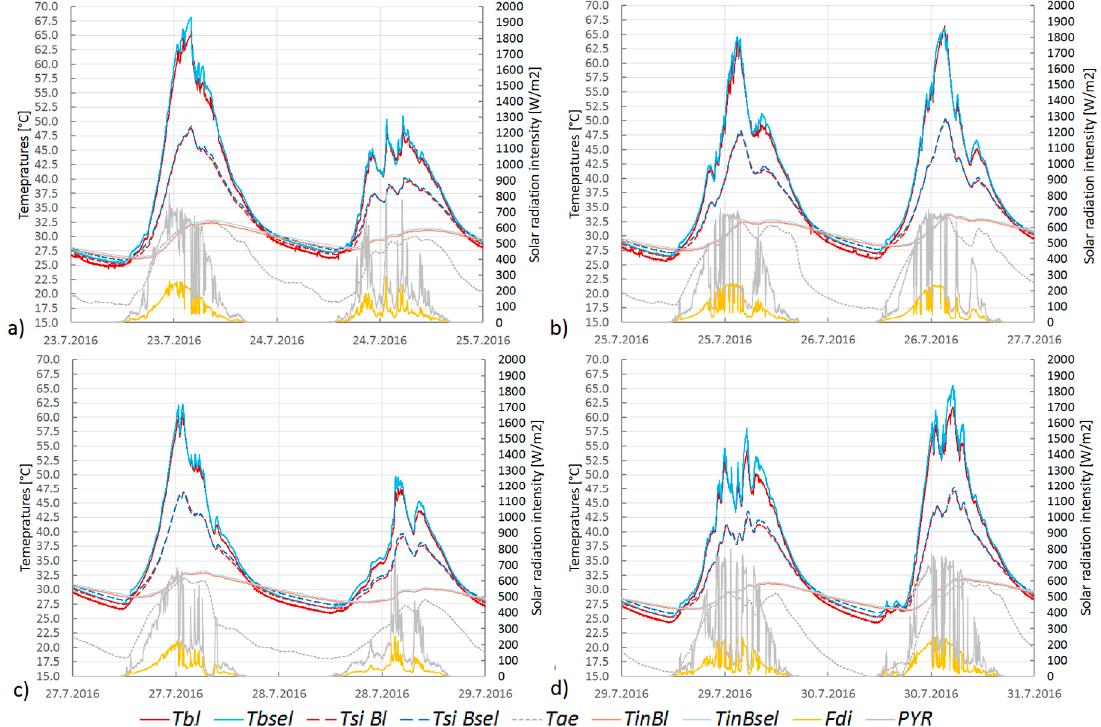
Figure 11. Full-scale test results of one-week period; ( a – d ) Temperature measurements behind absorbers and internal surface temperatures of tested components.